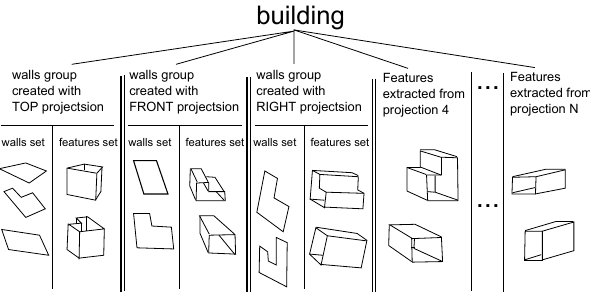
Figure 3. Data structure holding 3D representation of single building.